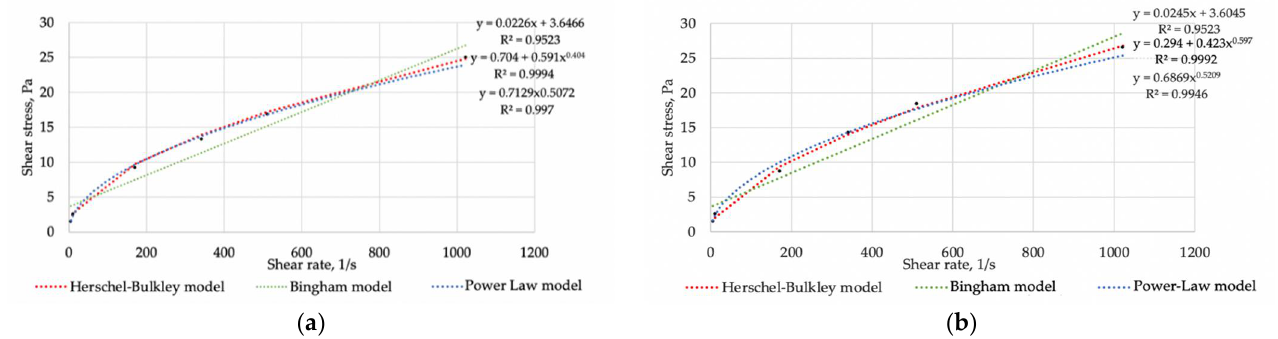
Figure 4. Selection of the rheological model for sample 2 with PHPA MM = 12 million ( a ) and for sample 3 with PHPA MM = 15 million ( b ).